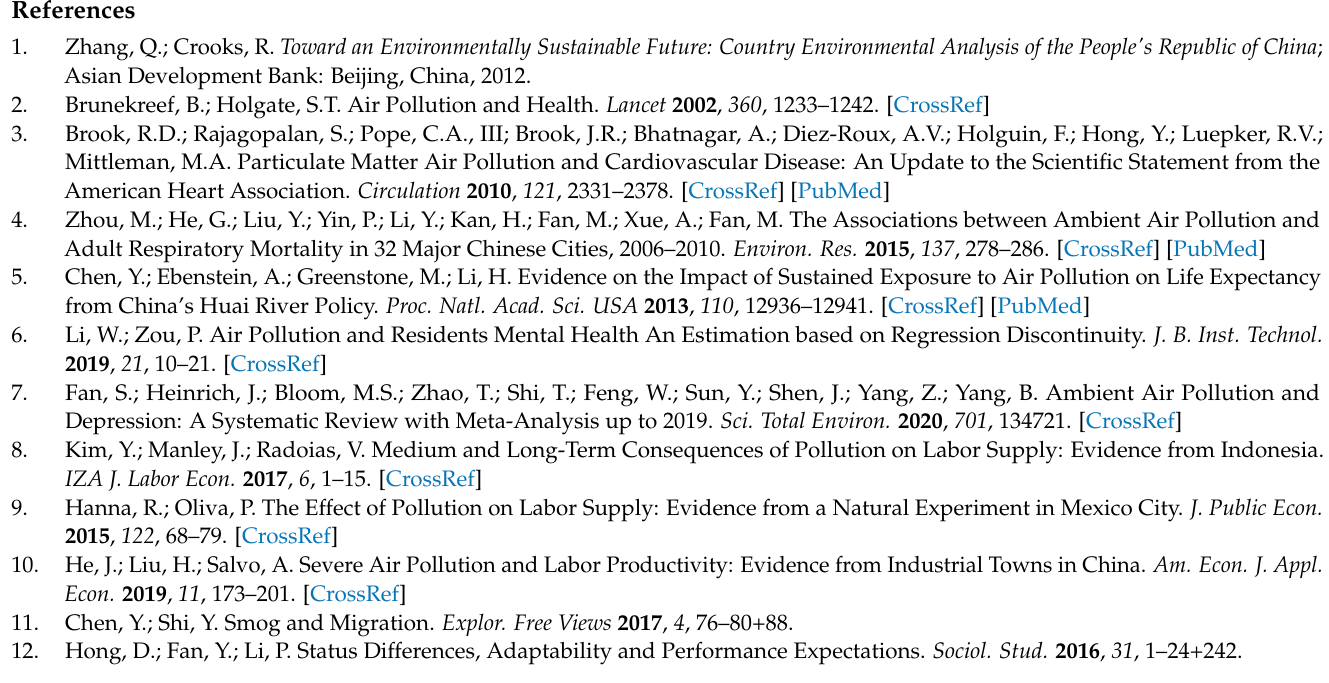
Figure A3. The average marginal effect of AQI.